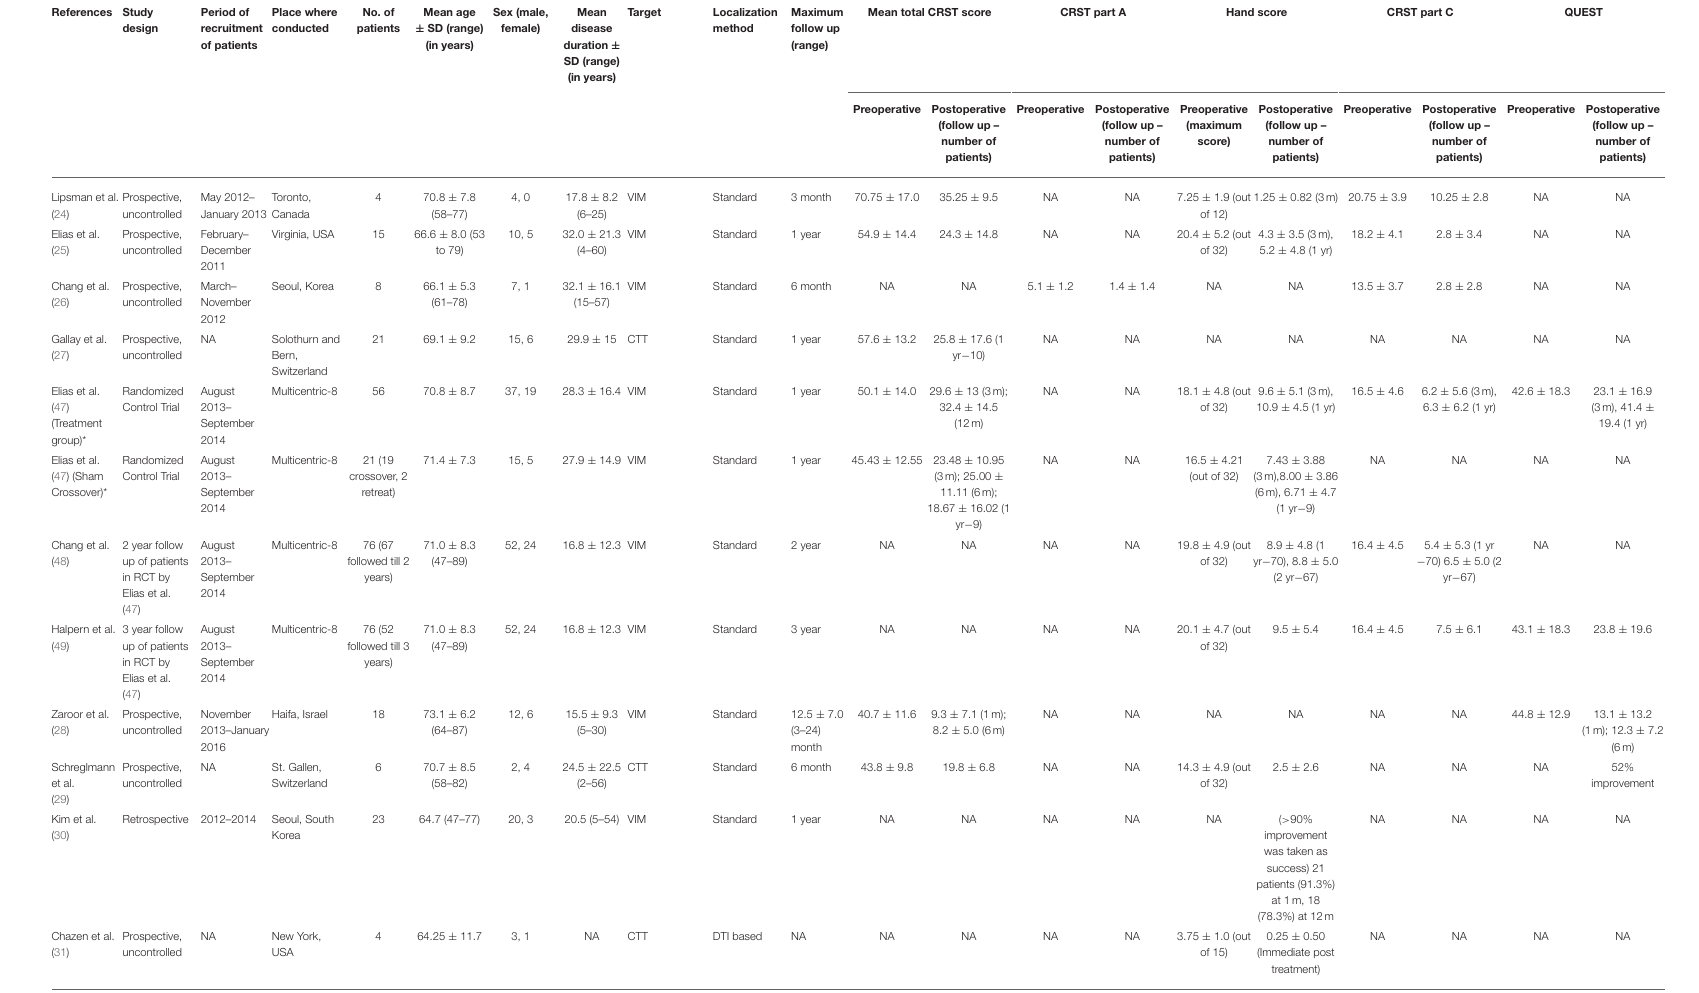
TABLE 2 | Study details arranged chronologically by the month and year of publication along with follow up and outcome scores [*For descriptive purposes, the cohort of patients reported by Krishna et al. (35) and Elias et al. ( 47) were split into two groups, each with its own distinct